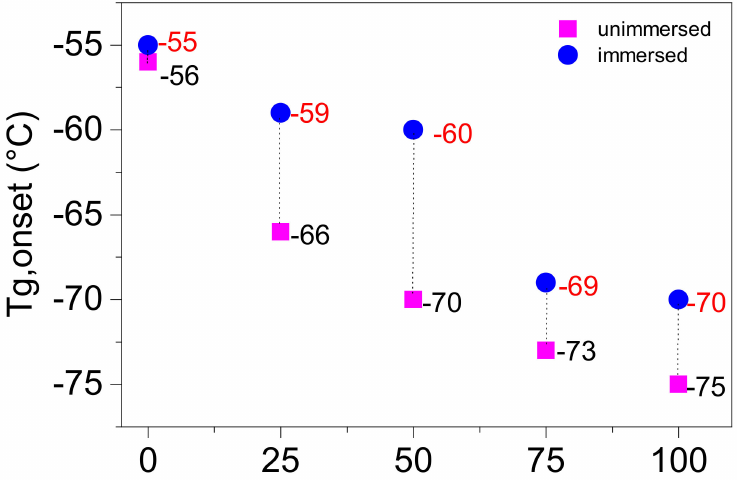
Figure 7. Glass transition temperature of the